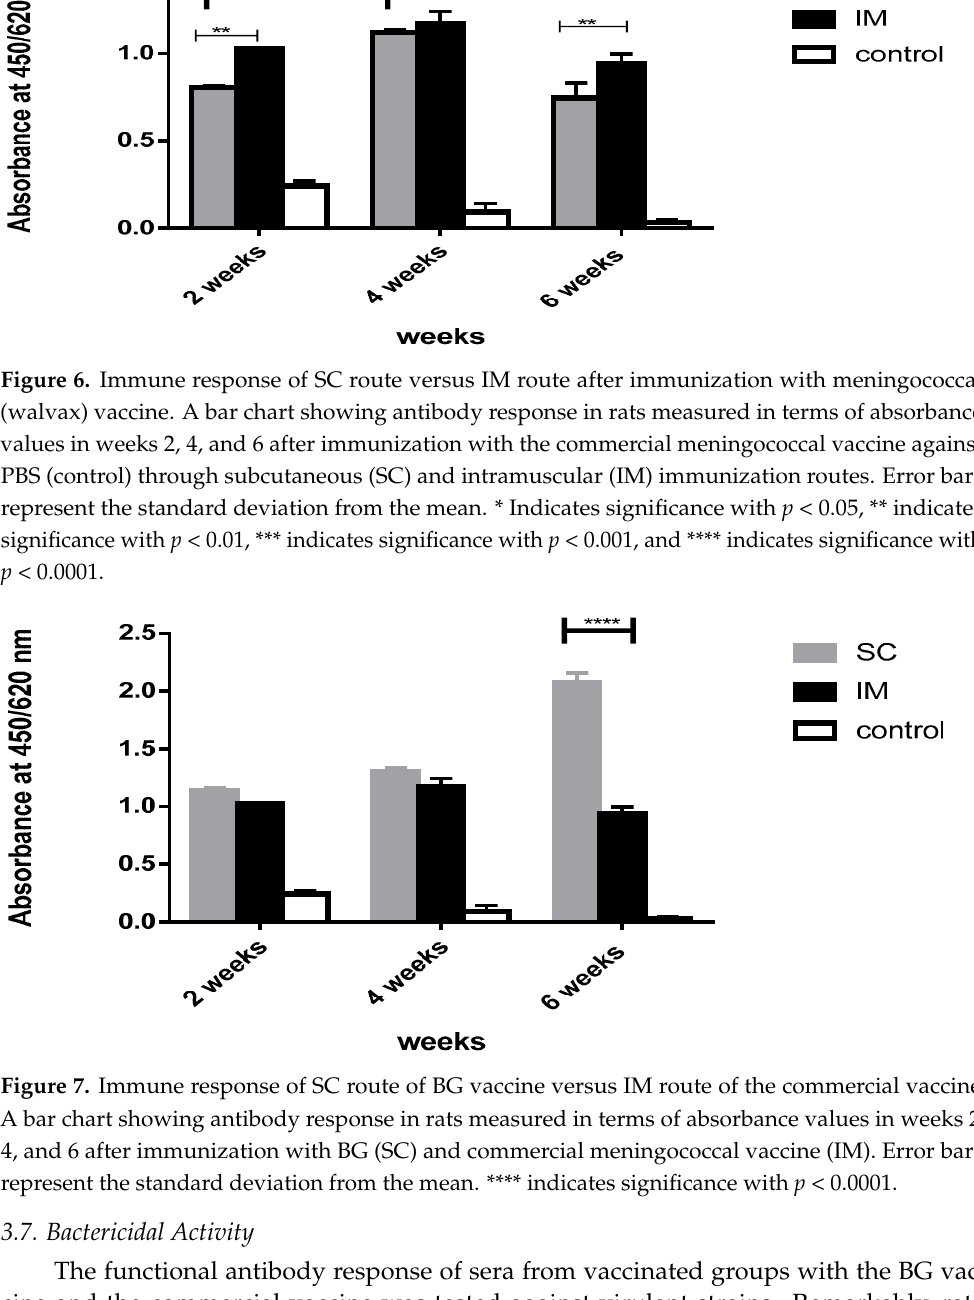
Figure 7. Immune response of SC route of BG vaccine versus IM route of the commercial vaccine. A bar chart showing antibody response in rats measured in terms of absorbance values in weeks 2, 4, and 6 after immunization with BG (SC) and commercial meningococcal vaccine (IM). Error bars represent the standard deviation from the mean. **** indicates significance with p < 0.0001.